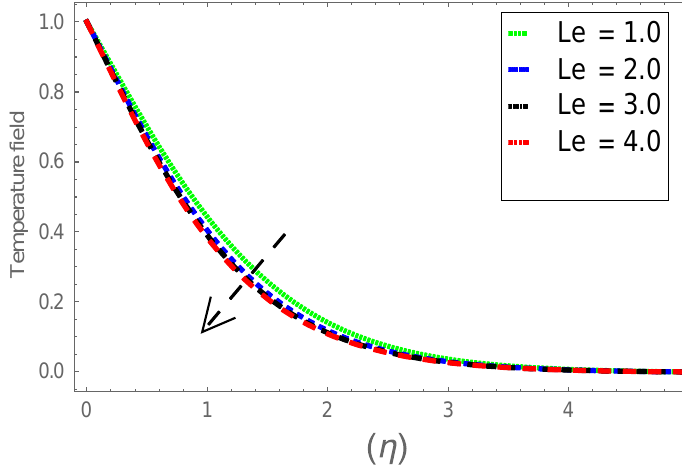
Coatings 2021 , 11 , x FOR PEER REVIEW